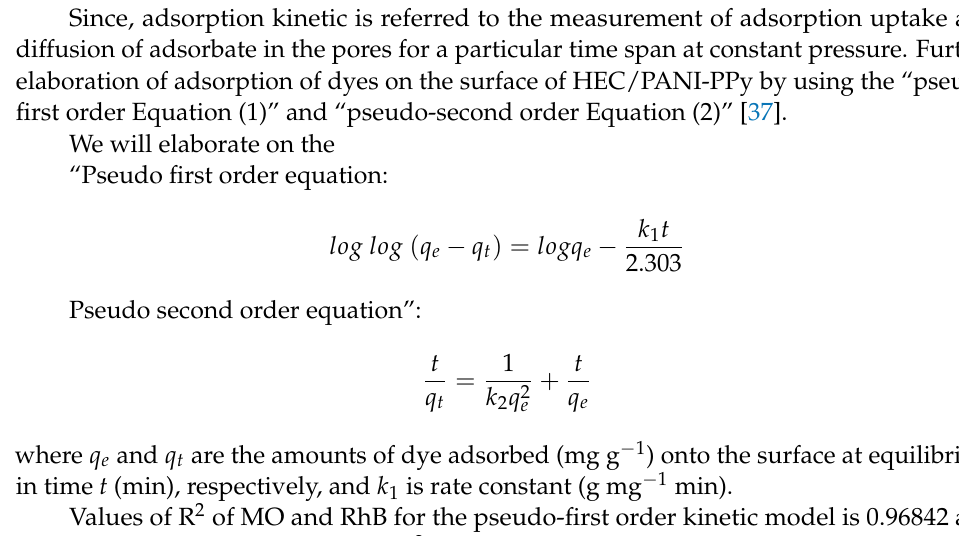
Figure 19. Adsorption kinetic curve for MO ( left ) and RhB ( right ).